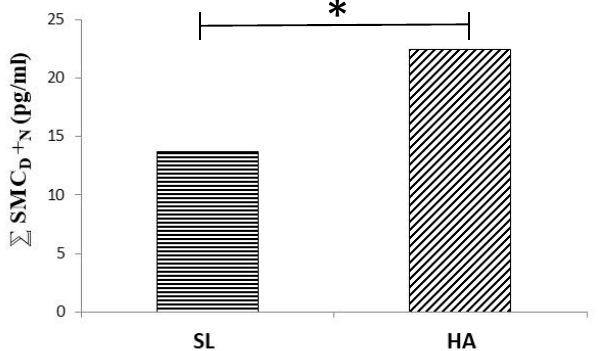
Figure 2. The sum of total (night and day) SMC at SL (left) and HA (right). Asterisk represents statistical di ff erence ( p < 0.05).